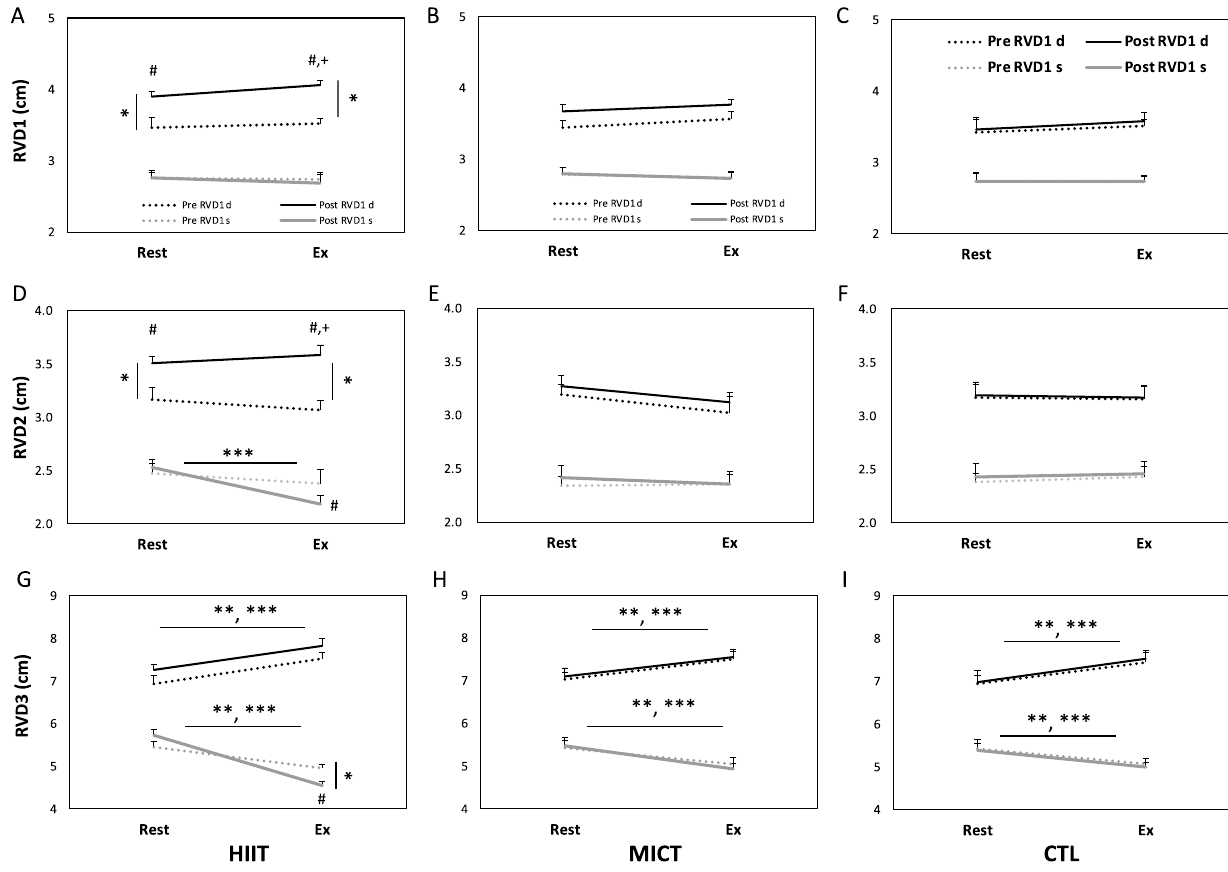
Figure 2. Comparisons of the effects of various exercise regimens on RV dimensions at rest or during HE. (A) RVD1 in HIIT; (B) RVD1 in MICT; (C) RVD1 in CTL; ( D) RVD2 in HIIT; (E) RVD2 in MICT; (F) RVD2 in CTL; ( G ) RVD3 in HIIT; ( H ) RVD3 in MICT; ( I ) RVD3 in CTL. HIIT, high-intensity interval training group; MICT, moderate-intensity continuous training group; CTL, control group; Pre RVD d, RVD in end-diastole before training; Post RVD d, RVD in end-diastole after training; Pre RVD s, RVD in end-systole before training; Post RVD s, RVD in end-systole after training. Values are the mean ± SEM. * P < 0.05, Pre vs. Post; ** P < 0.05, Pre-Rt vs. Pre-HE; *** P < 0.05, Post-Rt vs. Post-HE; + P < 0.05, HIIT vs. MICT; # P < 0.05, HIIT or MICT vs